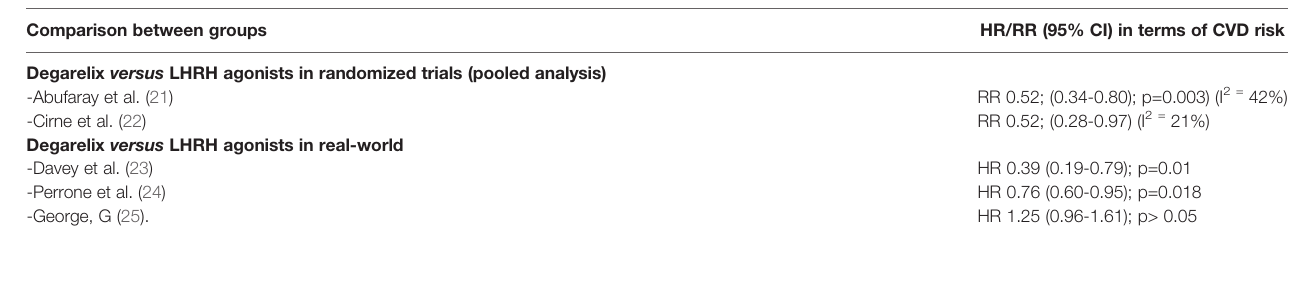
TABLE 2 | Comparison between Degarelix and LHRH agonists in terms of CVD risk. Comparison between groups Degarelix versus LHRH agonists in randomized trials (pooled analysis) -Abufaray et al.